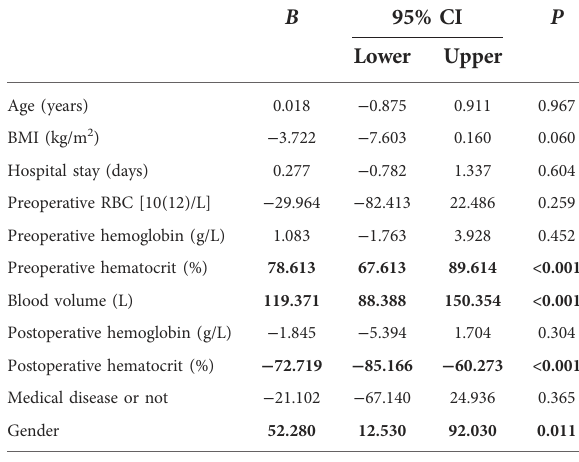
BMI, body mass index; RBC, red blood cell; CI, con fi dence interval. Bold values indicate data are statistically signi fi